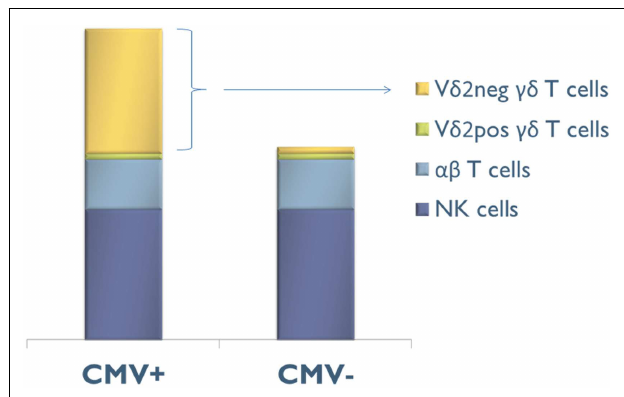
FIGURE 2 | Composition of the CD16 + lymphocyte compartment in CMV-seropositive (CMV + ) and CMV-seronegative (CMV − ) people . CMV infection doubles the number of circulating CD16 + lymphocytes, through this expansion of CD16 + V δ 2 neg γδ T cells.